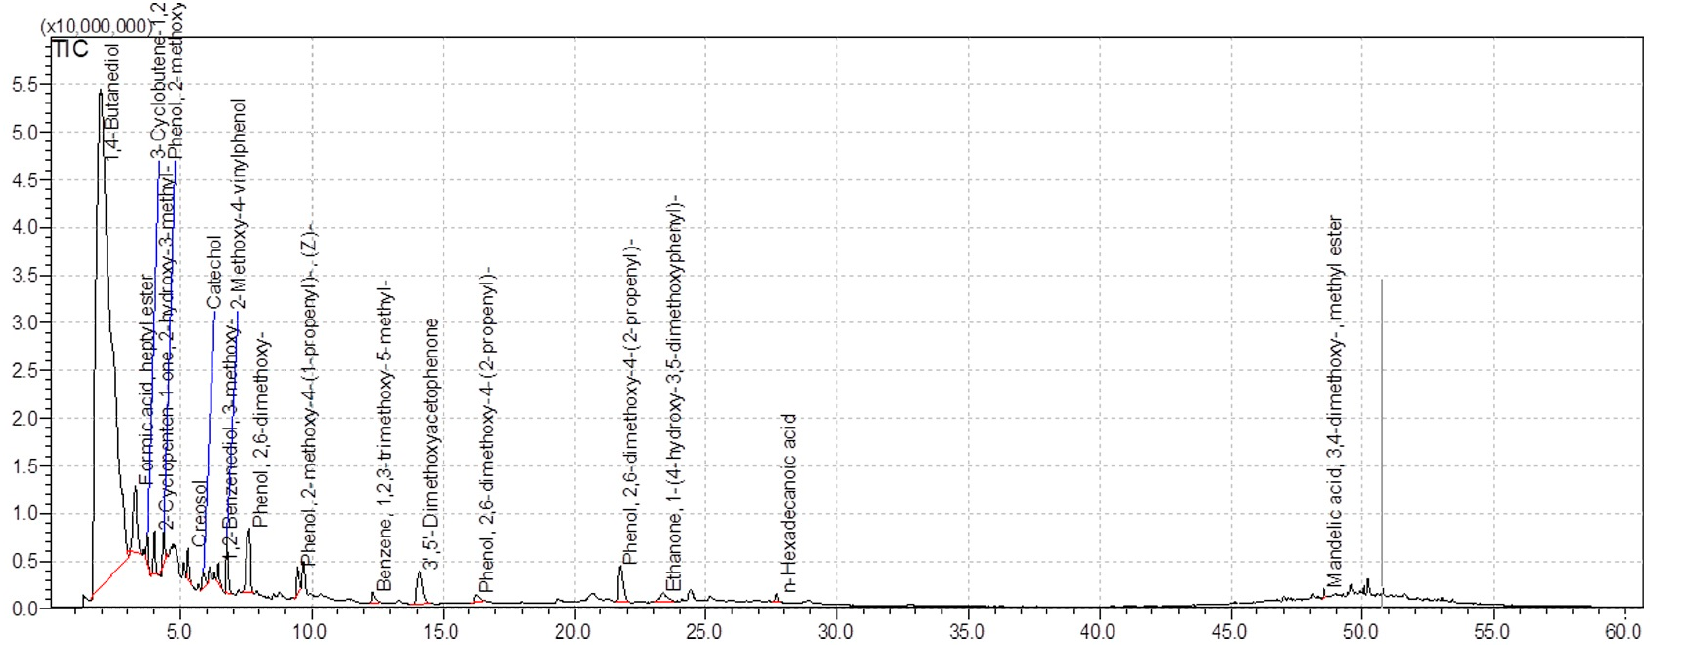
Figure 9. Emissions of isolated substances after pyrolysis at 450 °C.